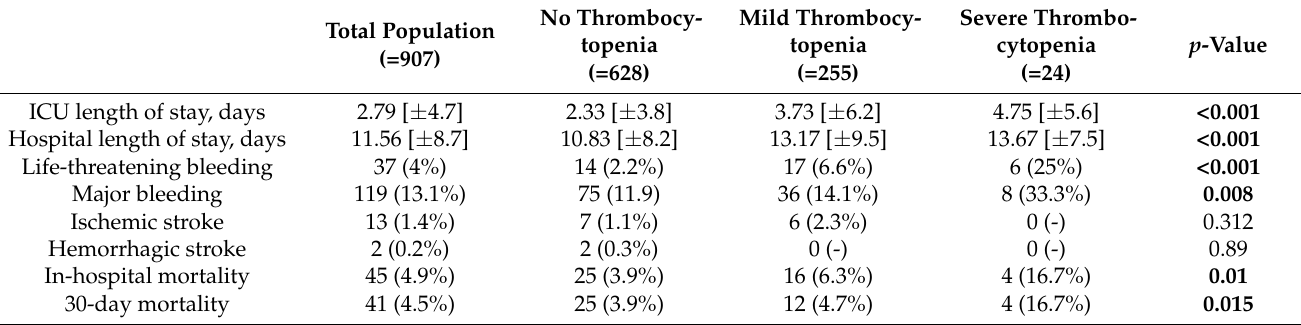
Table 2. Primary outcomes. Groups are defined according to the onset of postoperative thrombocy- topenia. Values are expressed as mean [ ± standard deviation] or n